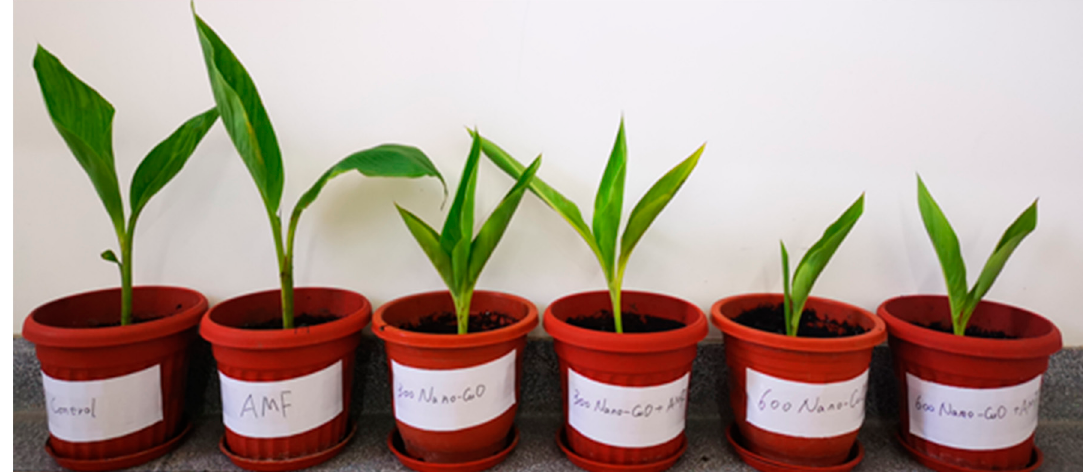
Figure 2. AMF enhanced C. indica seedling growth under nano-CuO stress. The test treatments from left to right: control treatment (without Cu or AMF); AMF (without Cu); nano-CuO (300 mg kg − 1 ); AMF + nano-CuO (300 mg kg − 1 ); nano-CuO (600 mg kg − 1 ); and AMF + Nano-CuO (600 mg kg − 1 ). We did not find AM colonization within non-inoculated seedling roots of C. indica , while C. indica roots were colonized by F. mosseae in the inoculated seedlings. All AMF inoculation treatments showed mycorrhizal colonization in C. indica roots. The mycorrhi- zal colonization varied among different nano-CuO treatments, ranging from 22.1% to 52.5% (Figure 3). The highest colonization was found in the AM fungal-inoculated treat- ment plants without nano-CuO stress. The nano-CuO concentration in the soil had a neg- ative impact on AM colonization.